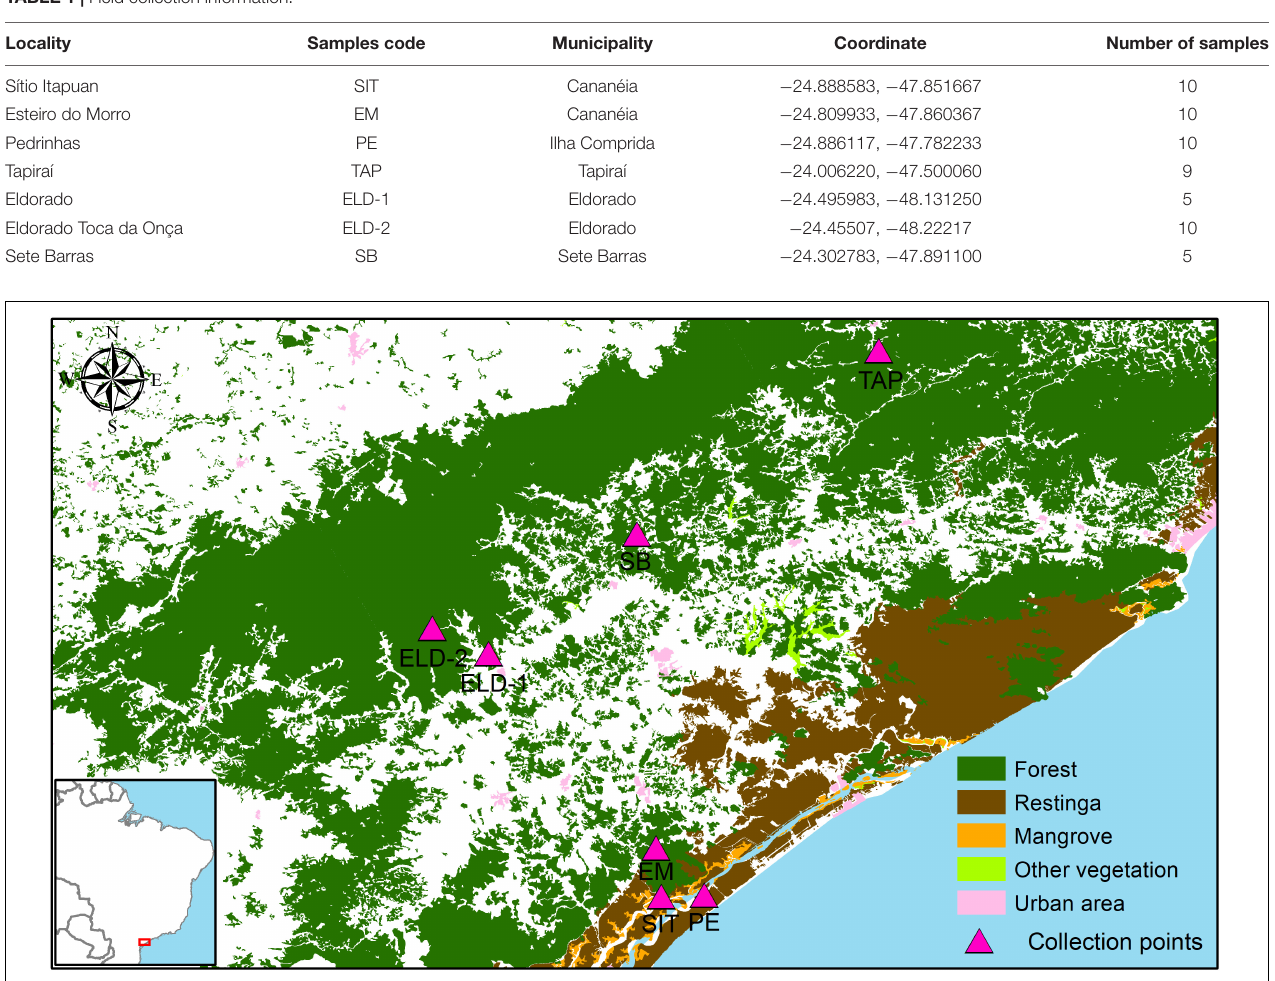
TABLE 1 | Field collection information.